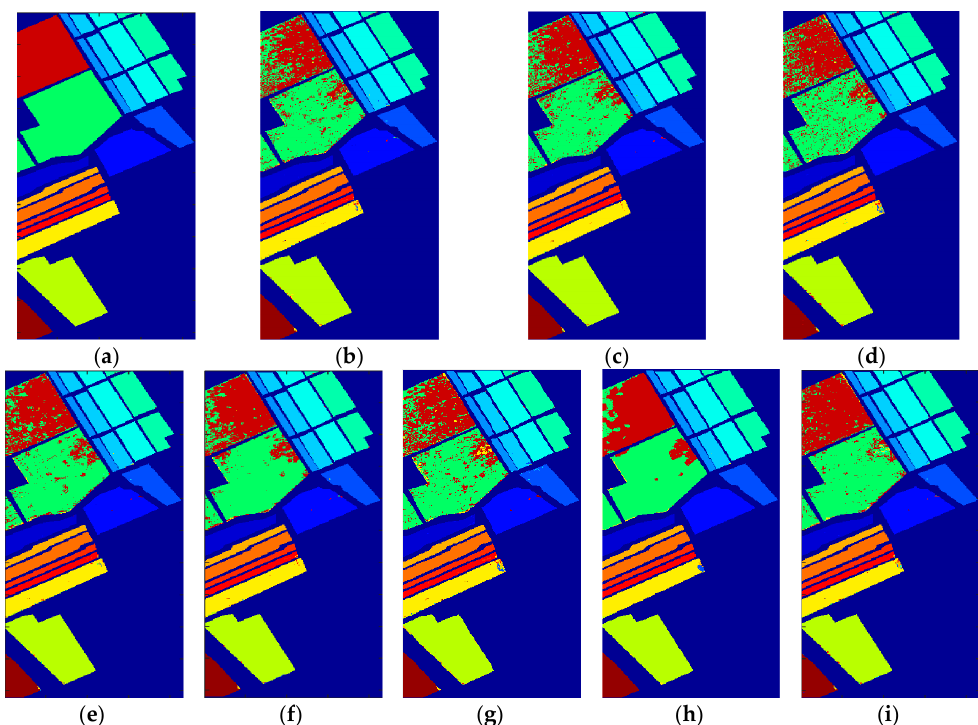
Figure 13. The classification maps obtained via different algorithms in University of Pavia: ( a ) Ground truth, ( b ) SVM, ( c ) RBFNN, ( d ) O_DBN, ( e ) SVM_TFE, ( f ) RBFNN_TFE, ( g ) CNN, ( h ) EFP-G-c and ( i ) the proposed framework.